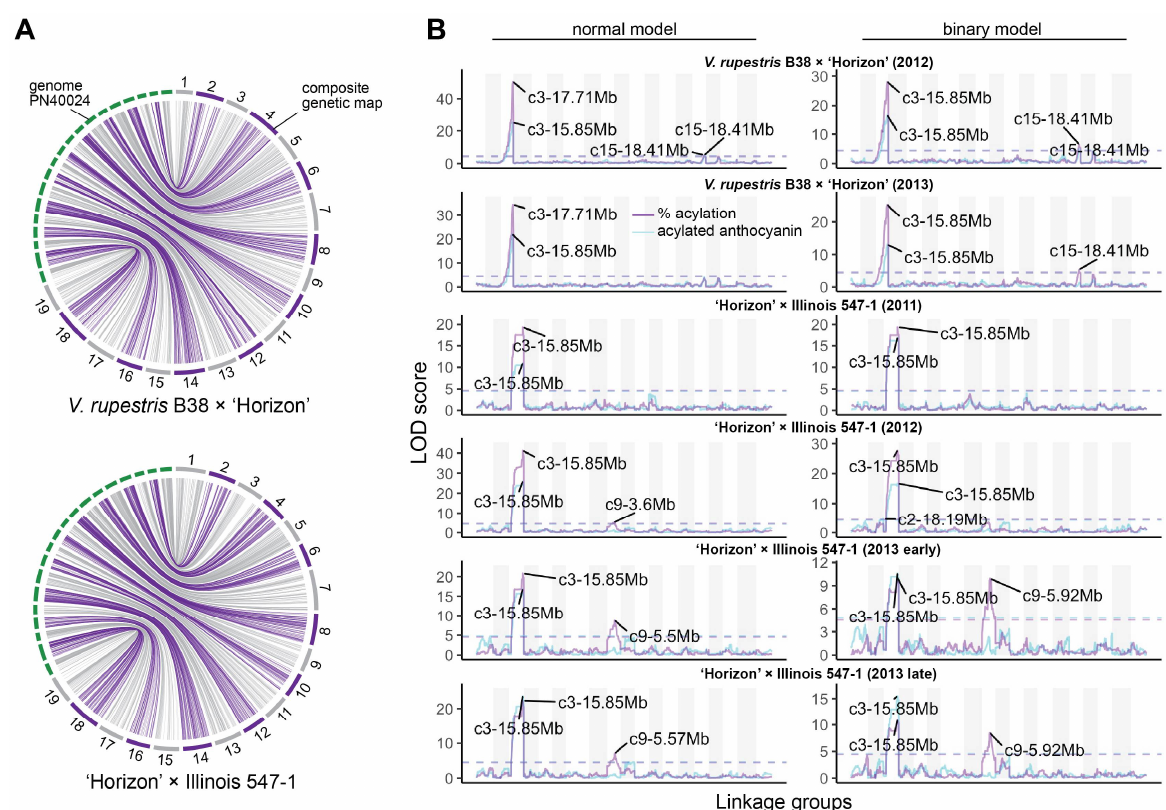
Figure 2. Linkage maps and QTL mapping of anthocyanin acylation. ( A ) Collinearity between physical (PN40024 reference genome) and composite genetic maps for the V. rupestris B38 × ‘Horizon’ and ‘Horizon’ × Illinois 547-1 populations. ( B ) Genetic mapping results for each population and evaluation year; QTL mapping was performed using both total acylated anthocyanins (blue line) as well as acylation ratio (purple line); additionally, normal and binary (high vs. low acylation ratio) models were compared for each population/year; dashed lines represent permutation-based significance